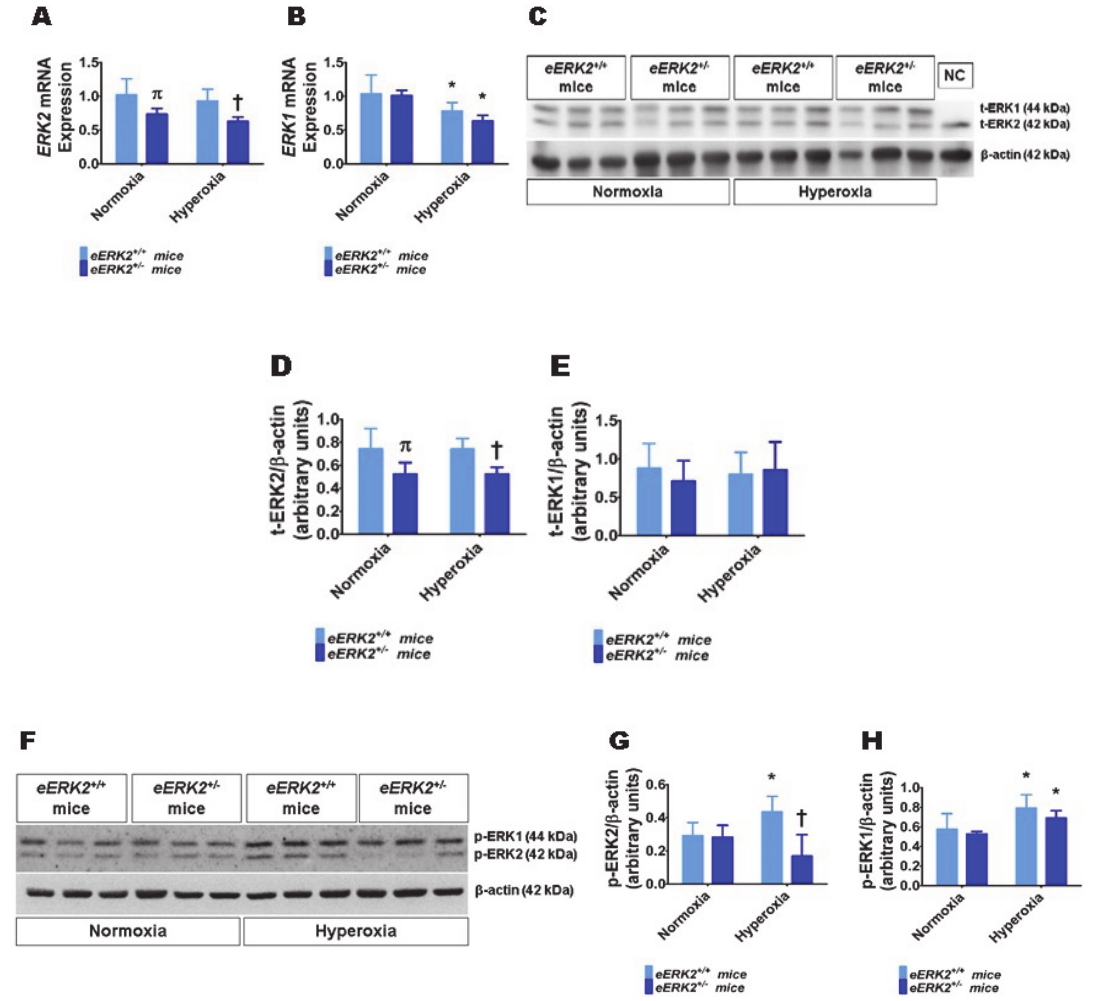
Figure 2. ERK1 and ERK2 mRNA and protein expression in the lungs of endothelial ERK2 -sufficient ( eERK2 +/+ ) or -deficient ( eERK2 +/ − ) mice. One-day-old eERK2 +/+ or eERK2 +/ − mice were exposed to either 21% O 2 (normoxia) or 70% O 2 (hyperoxia) for one week, after which the lungs were harvested for gene and protein expression studies. ( A , B ) RT-PCR analysis-based determination of ERK2 ( A ) and ERK1 ( B ) mRNA levels. ( C ) Determination of total (t)-ERK1 and -ERK2 protein levels by immunoblotting. NC: negative control (lung sample from global ERK1 knockout mice). ( D , E ) Quantification and normalization of t-ERK2 ( D ) and t-ERK1 ( E ) band intensities to those of β -actin. ( F ) Determination of phosphorylated (p)-ERK1 and -ERK2 protein levels by immunoblotting. ( G , H ) Quantification and normalization of p -ERK2 ( G ) and p-ERK1 ( H ) band intensities to those of β -actin. Values are presented as mean ± SD ( n = 5–6/genotype/exposure). Significant differences between eERK2 +/+ and eERK2 +/ − mice in normoxic and hyperoxic conditions are indicated by π , p < 0.05 and †, p < 0.05, respectively. Significant differences between normoxia and hyperoxia groups are indicated by *, p < 0.05 (ANOVA).